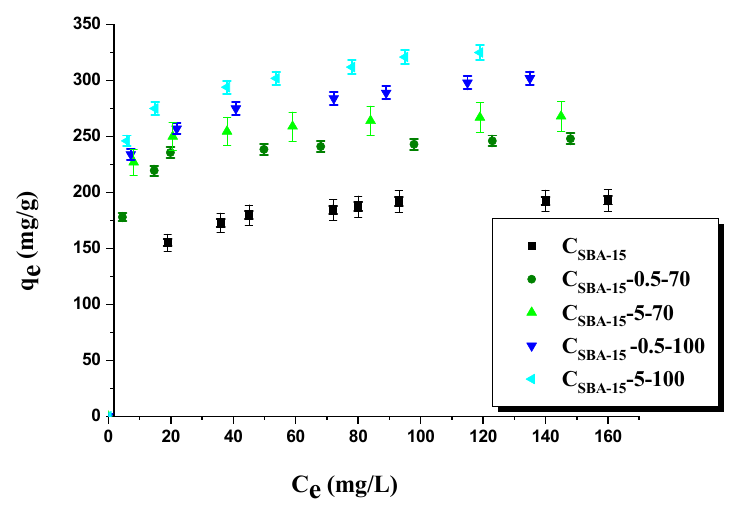
Figure 7. Adsorption of rhodamine B onto adsorbents obtained.